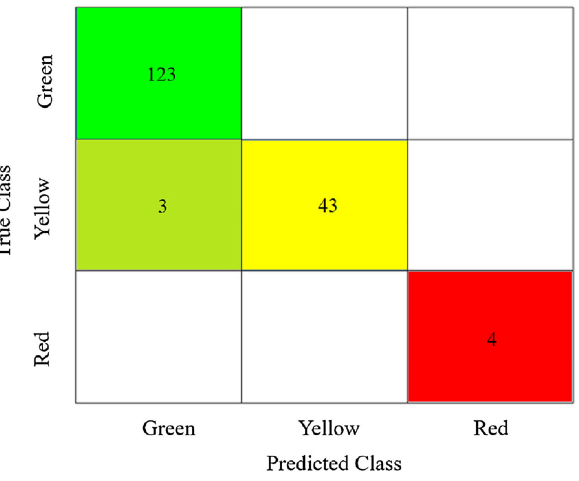
Fig. 10 Confusion matrix of the utility pole condition classification result of the 173 utility poles at the Beaumont Texas case study